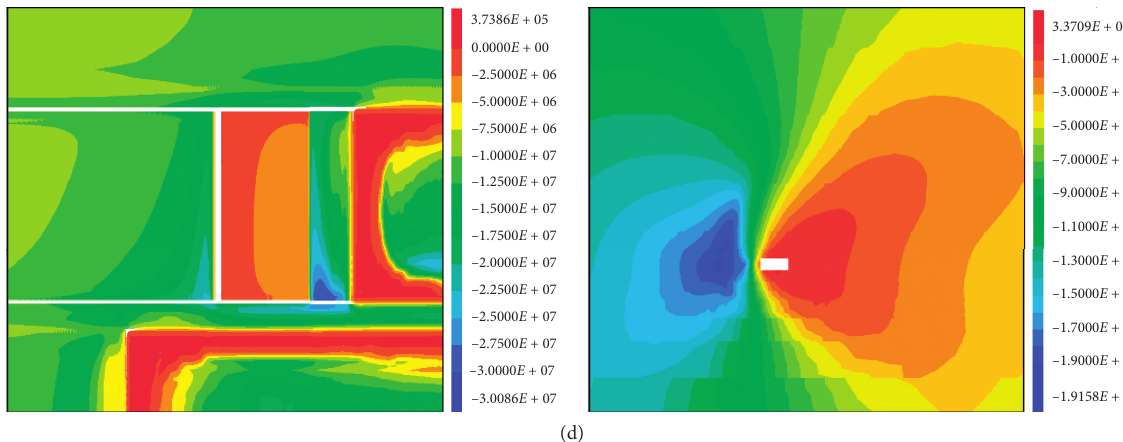
Figure 7: Nephogram of stress distribution 100 m away from the cut hole in E1302 working face under a backfilling mining cycle. (a) Vertical stress distribution before cutting the first coal. (b) Vertical stress distribution before cutting the second coal. (c) Vertical stress distribution before backfilling. (d) Vertical stress distribution before the next coal cutting after